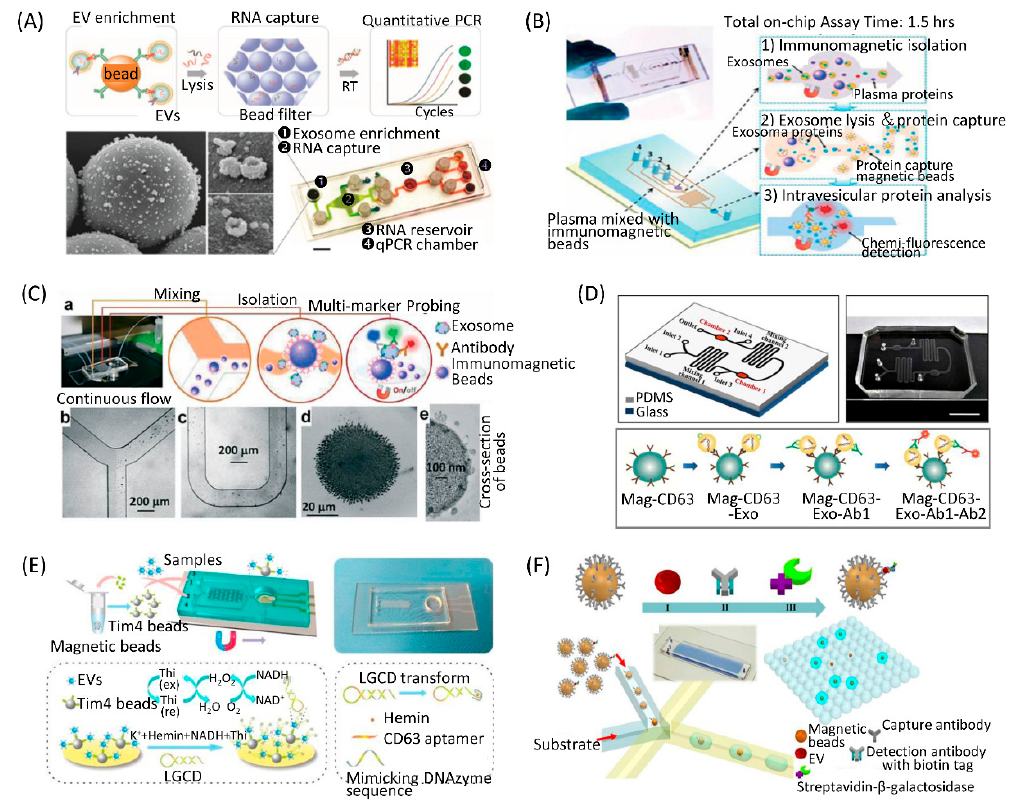
Figure3. Immunoaffinityseparationviamagneticnanoparticlesonmicrofluidicchips. ( A )Amicrofluidic Figure 3. Immunoaffinity separation via magnetic nanoparticles on microfluidic chips. ( A ) A platform containing EV enrichment and EV RNA analysis units. Reprinted with permission